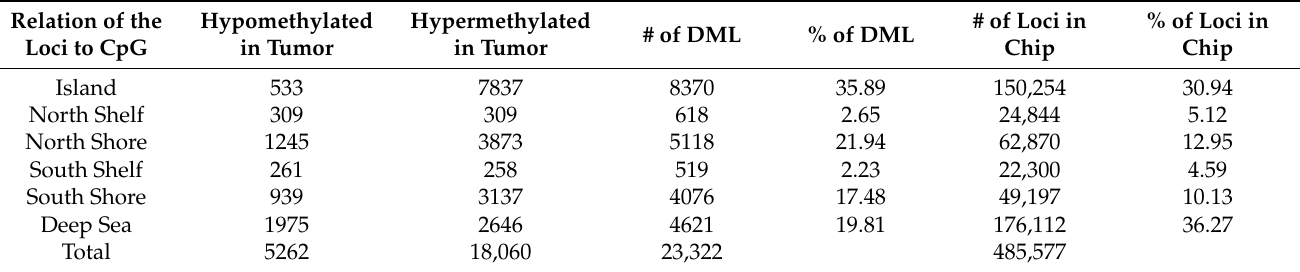
Table 2. Distribution of the 23,322 DML showing interactions with MSI by relation to CpG island. Relation of the Loci to